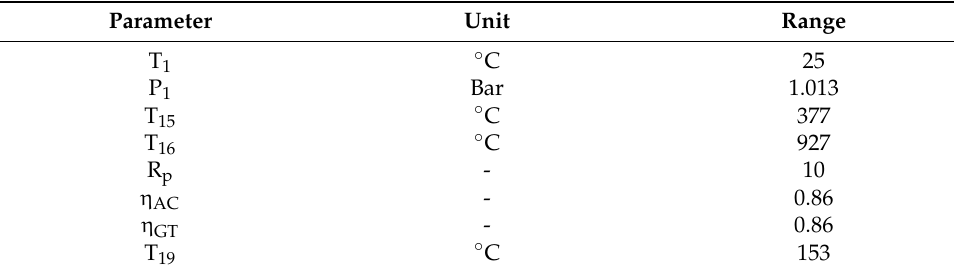
Table 5. Constant values for the Cogeneration system